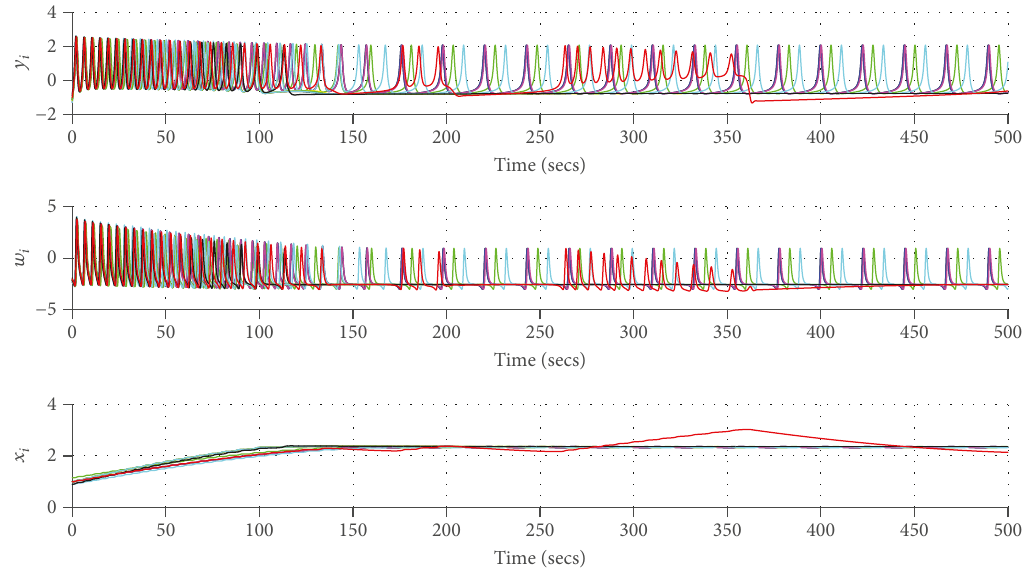
Figure 3: Behavior of an islet with ten β -cells of which fi ve are active and fi ve are inactive.